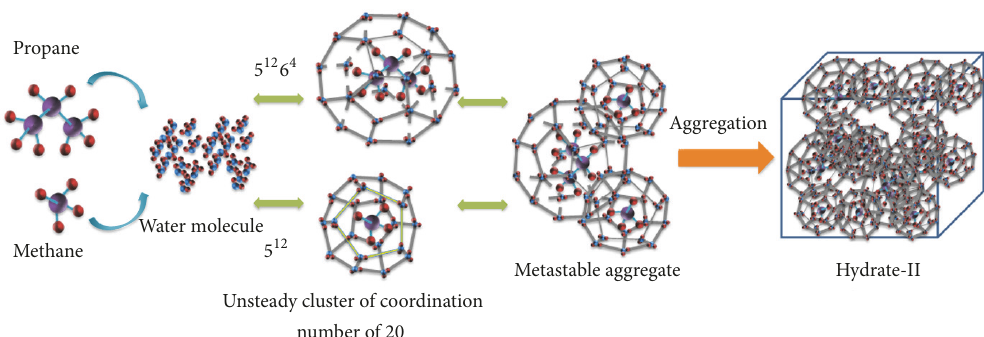
Figure 8: The synergistic nucleation process of methane and